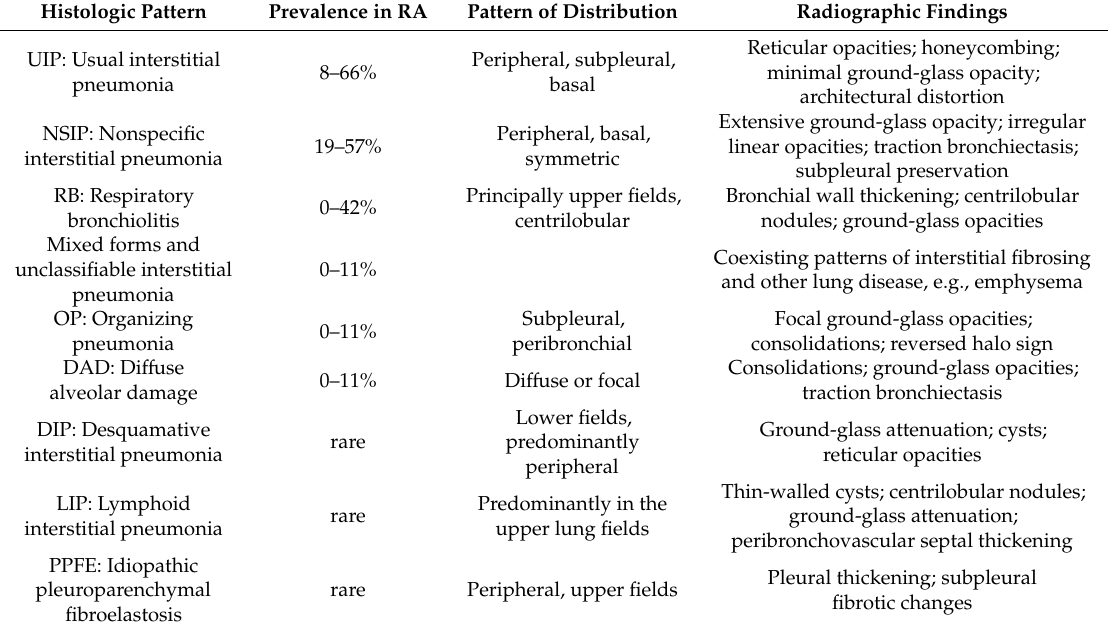
Table 2. Histologic classification and typical features of idiopathic interstitial pneumonia,.applicable to rheumatoid arthritis RA-ILD interstitial lung disease